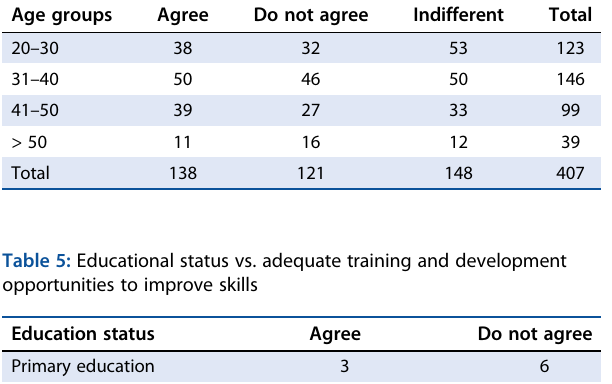
Table 4: Relationship between age and stipend ( n = 407) Age groups